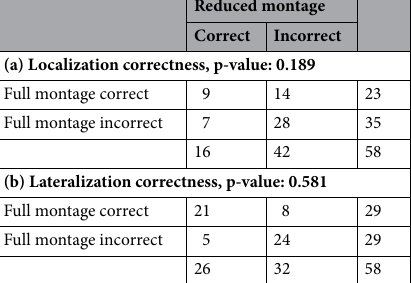
Reduced montage Correct